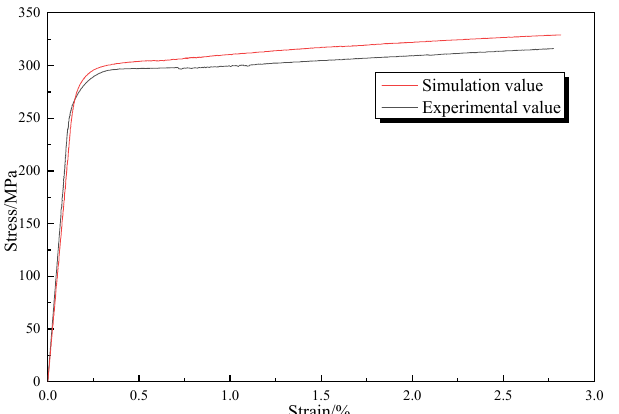
Figure 8. Comparison of simulated and tested tensile stress-strain curves of the material after siliconization at 1200 °C for 120 s.